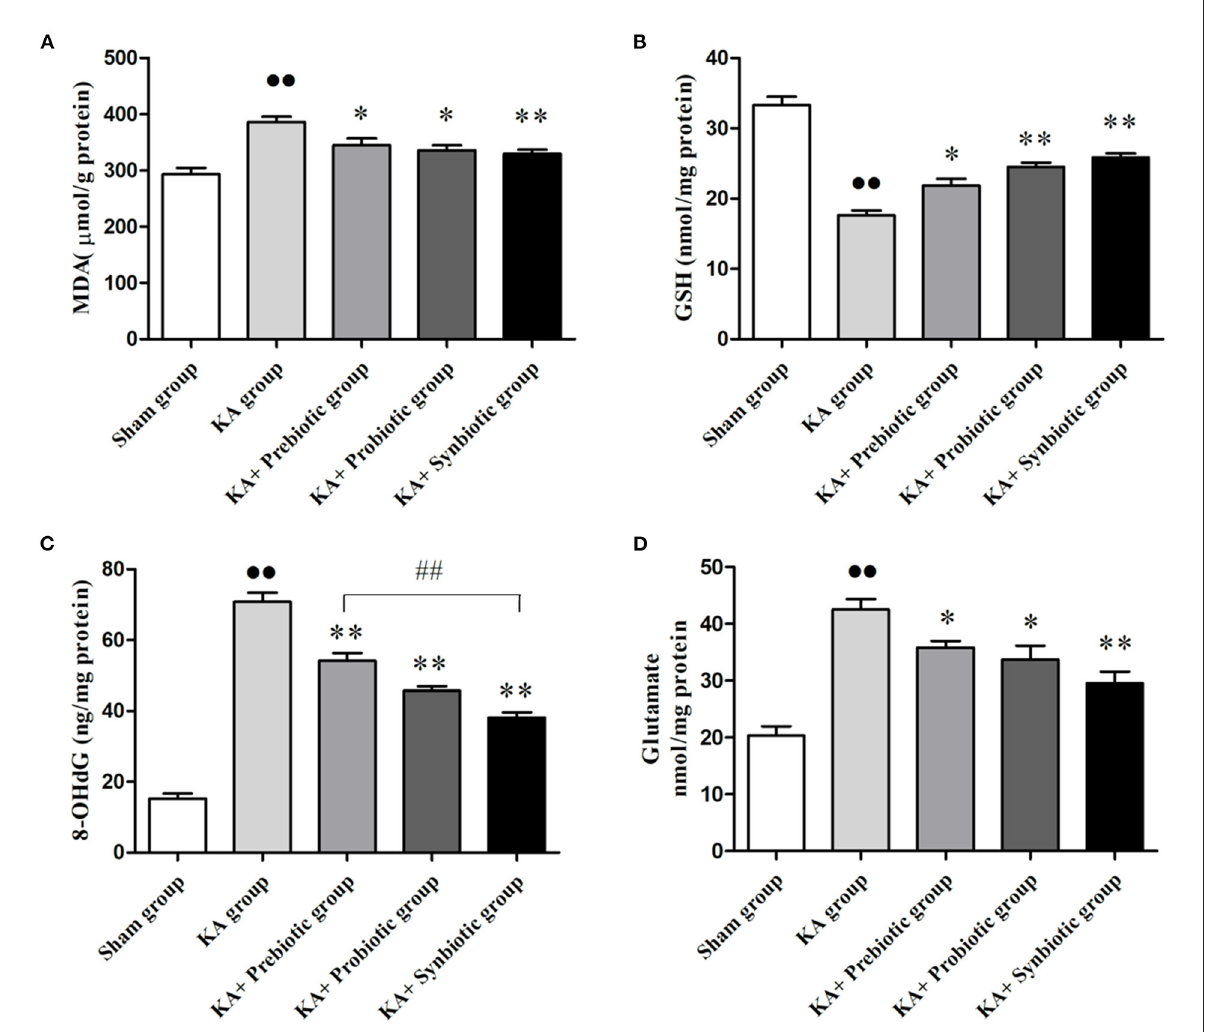
FIGURE3 Treatment with prebiotics, probiotics, and synbiotics reduced the levels of MDA, 8-OHdG, and glutamate and increased the level of GSH in the hippocampus of rats after status epilepticus induction. (A) MDA. (B) GSH. (C) 8-OHdG. (D) Glutamate. •• P < 0.01 vs. the Sham group, * P < 0.05 vs. the KA group, ** P < 0.01 vs. the KA group, ## P < 0.01 vs. the KA + synbiotic group. KA, kainic acid.